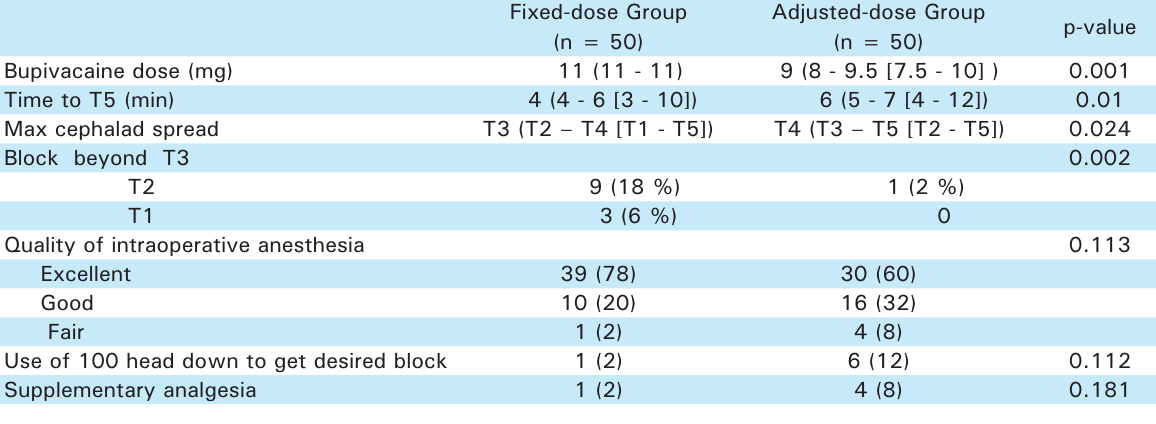
Table 3. Bupivacaine dose, spinal block characteristics and effi cacy